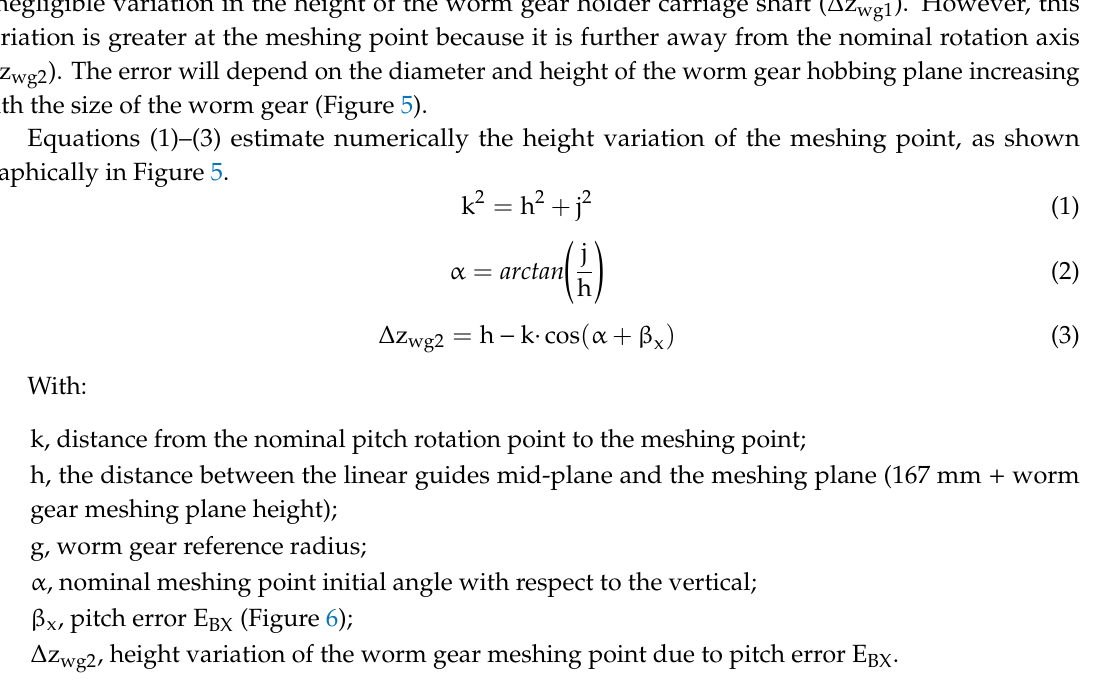
Figure 6. Pitch error (E BX ). Likewise, if the calculations of the possible variations in the same movement direction are made, Δ xwg1 and Δ xwg2 (see Figure 5), it can be seen that both values are very similar according to Equations (4) and (5). Thus, their difference is negligible (below 1 μ m) so this variation can be